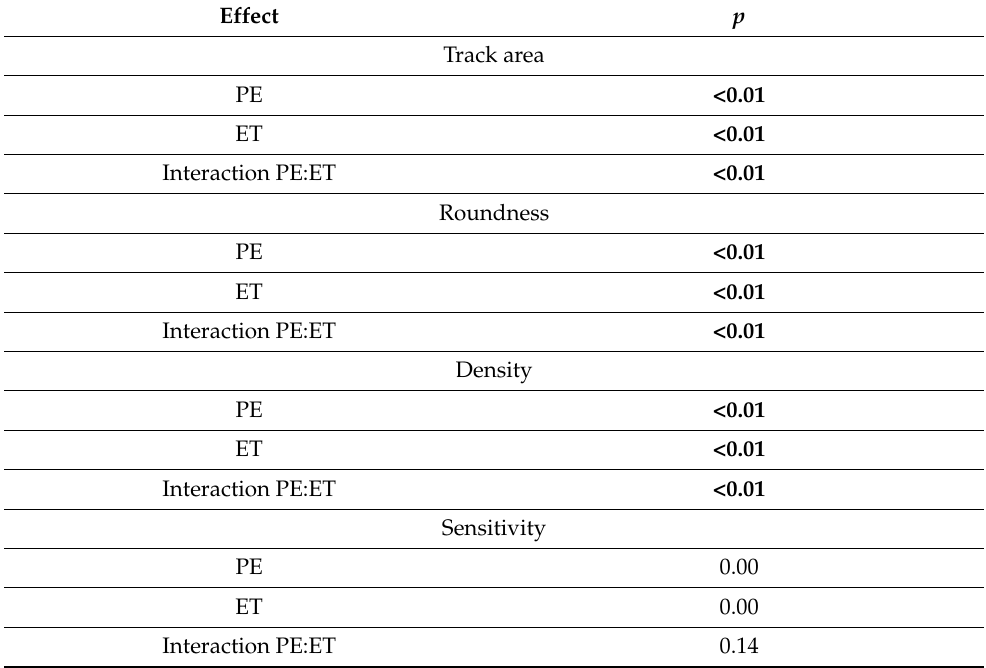
Table 11. ANOVA results for radon exposure in Experiment 2